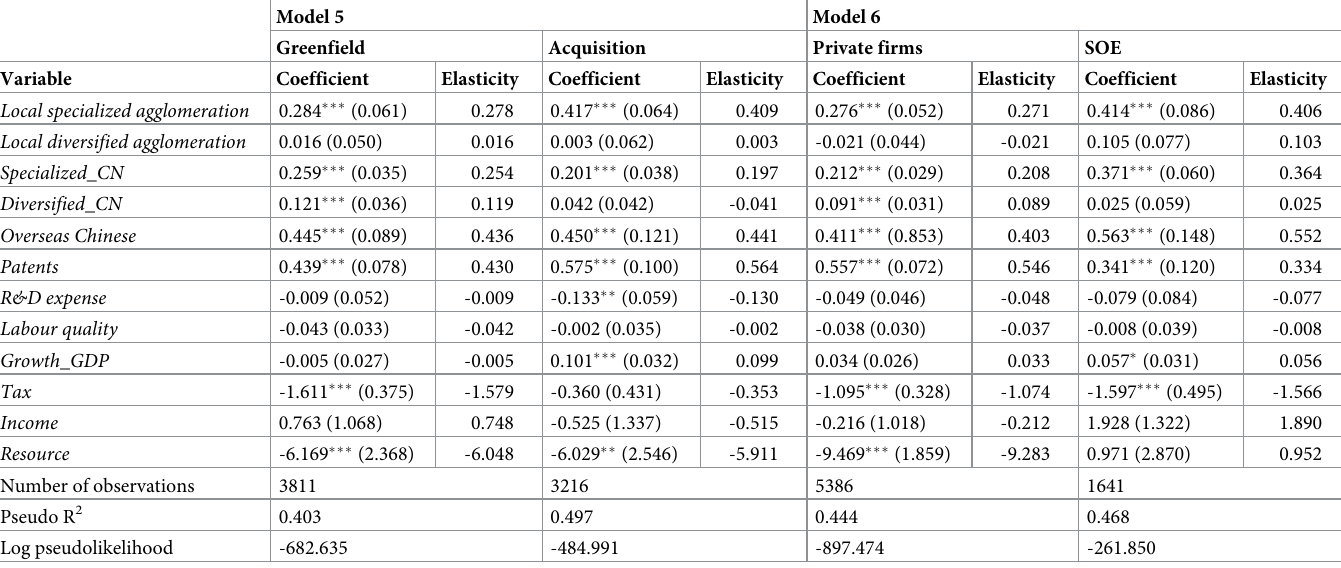
Table 5. Conditional logit estimation for CODI in the United States according to entry modes and